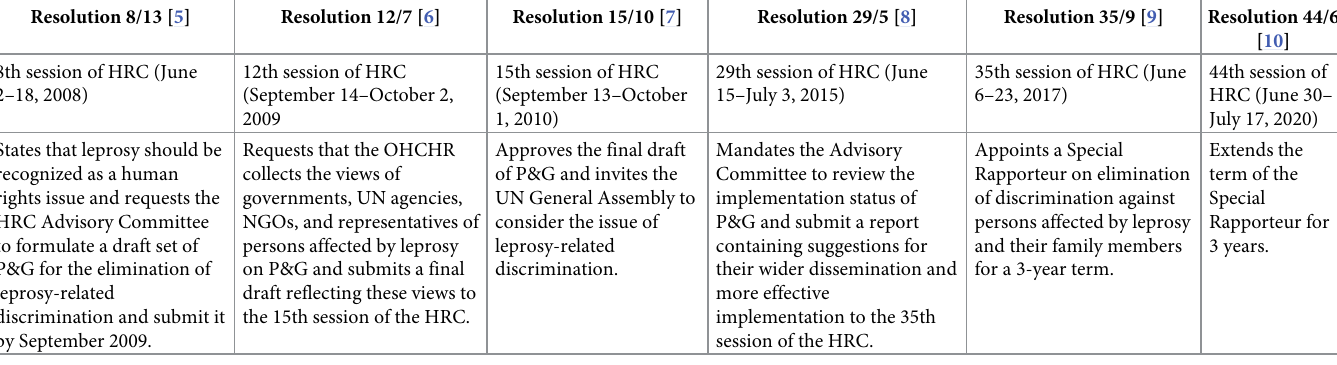
Table 1. Overview of HRC